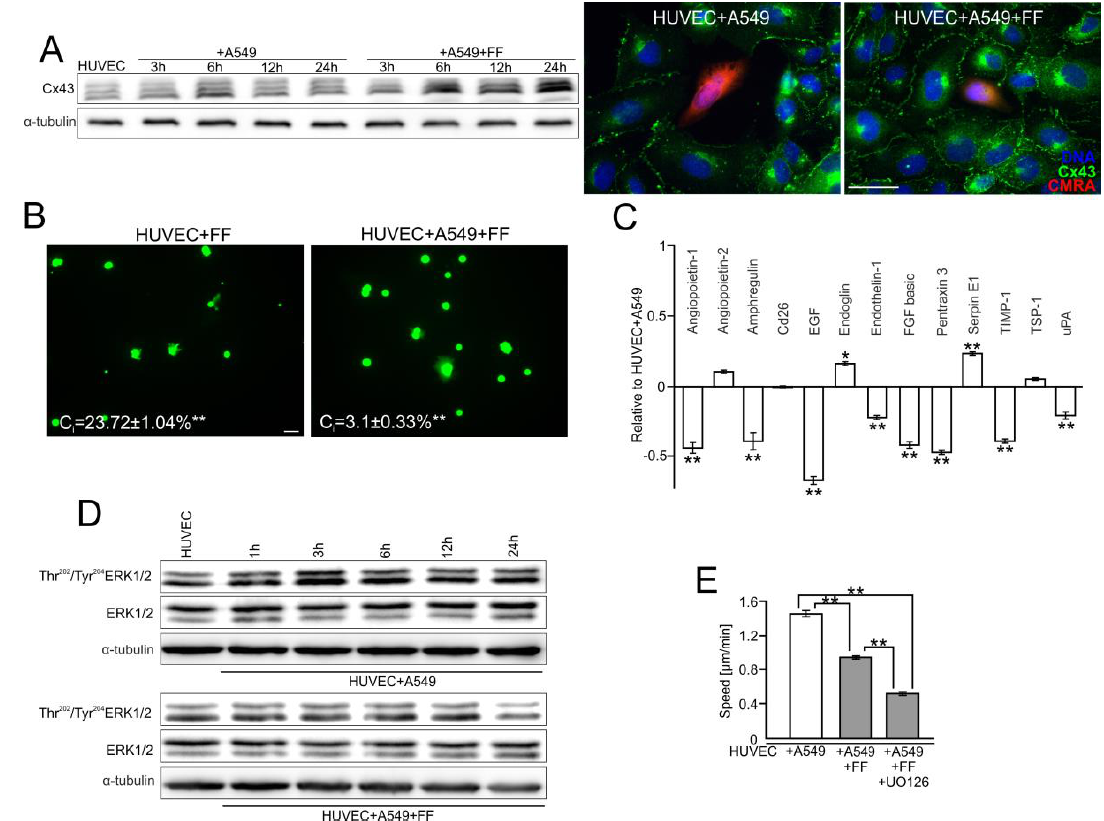
Figure 3. Fenofibrate interferes with the communication networks established between HUVEC and A549 cells. ( A ) HUVEC/A549 co-cultures were established as in Figure 1 and cultivated in the absence or presence of 25 μM FF. Cx43 levels were analyzed at the indicated time points by immunoblotting, quantified by densitometry (Figure S5A,B) and visualized by immunofluorescence after 6 h. ( B ) Calcein-loaded HUVEC (left) or A549 cells (right) were seeded onto HUVEC monolayers and the effect of FF on GJIC (coupling ratio-Ci) was estimated by calcein transfer assay after 1 h. ( C ) Expression of angioactive proteins in FF-treated HUVEC/A549 co-culture was semi-quantitively estimated by the antibody array kit. Plots show the densitometrically estimated dot intensities, illustrating the amounts of a given factor in HUVEC/A549 cells in the presence of 25 μM FF (24 h; relative to HUVEC/A549 control). ( D ) HUVEC/A549 co-cultures were cultivated in the absence or in the presence of 25 μM FF. Tyr 202/204 ERK1/2 levels were analyzed at the indicated time points by immunoblotting and quantified by densitometry (Figure S5C). ( E ) HUVEC/A549 co-cultures were established as above and cultivated in the presence of 25 μM FF. The effect of the ERK1/2 inhibitor (UO126) on HUVEC activation was analyzed with time-lapse videomicroscopy. Error bars represent SEM. Scale bar = 40 μm. The statistical significance of the differences was tested with one-way ANOVA followed by post-hoc Tukey’s HSD ( B ) or non-parametric Dunnett comparison ( A – E ); * p < 0.05; ** p < 0.01. All results are representative of a least three independent experiments ( n ≥ 3). Note that FF administration inhibits GJIC between cancer and endothelial cells, abolishes the induction of EGF secretion, and inhibits A549-induced motility of HUVECs.